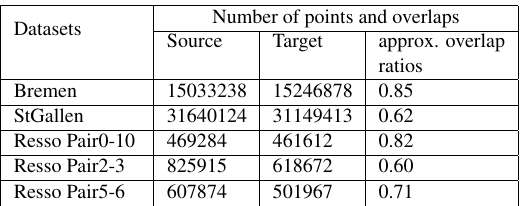
Table 1. Detailed information of experimental